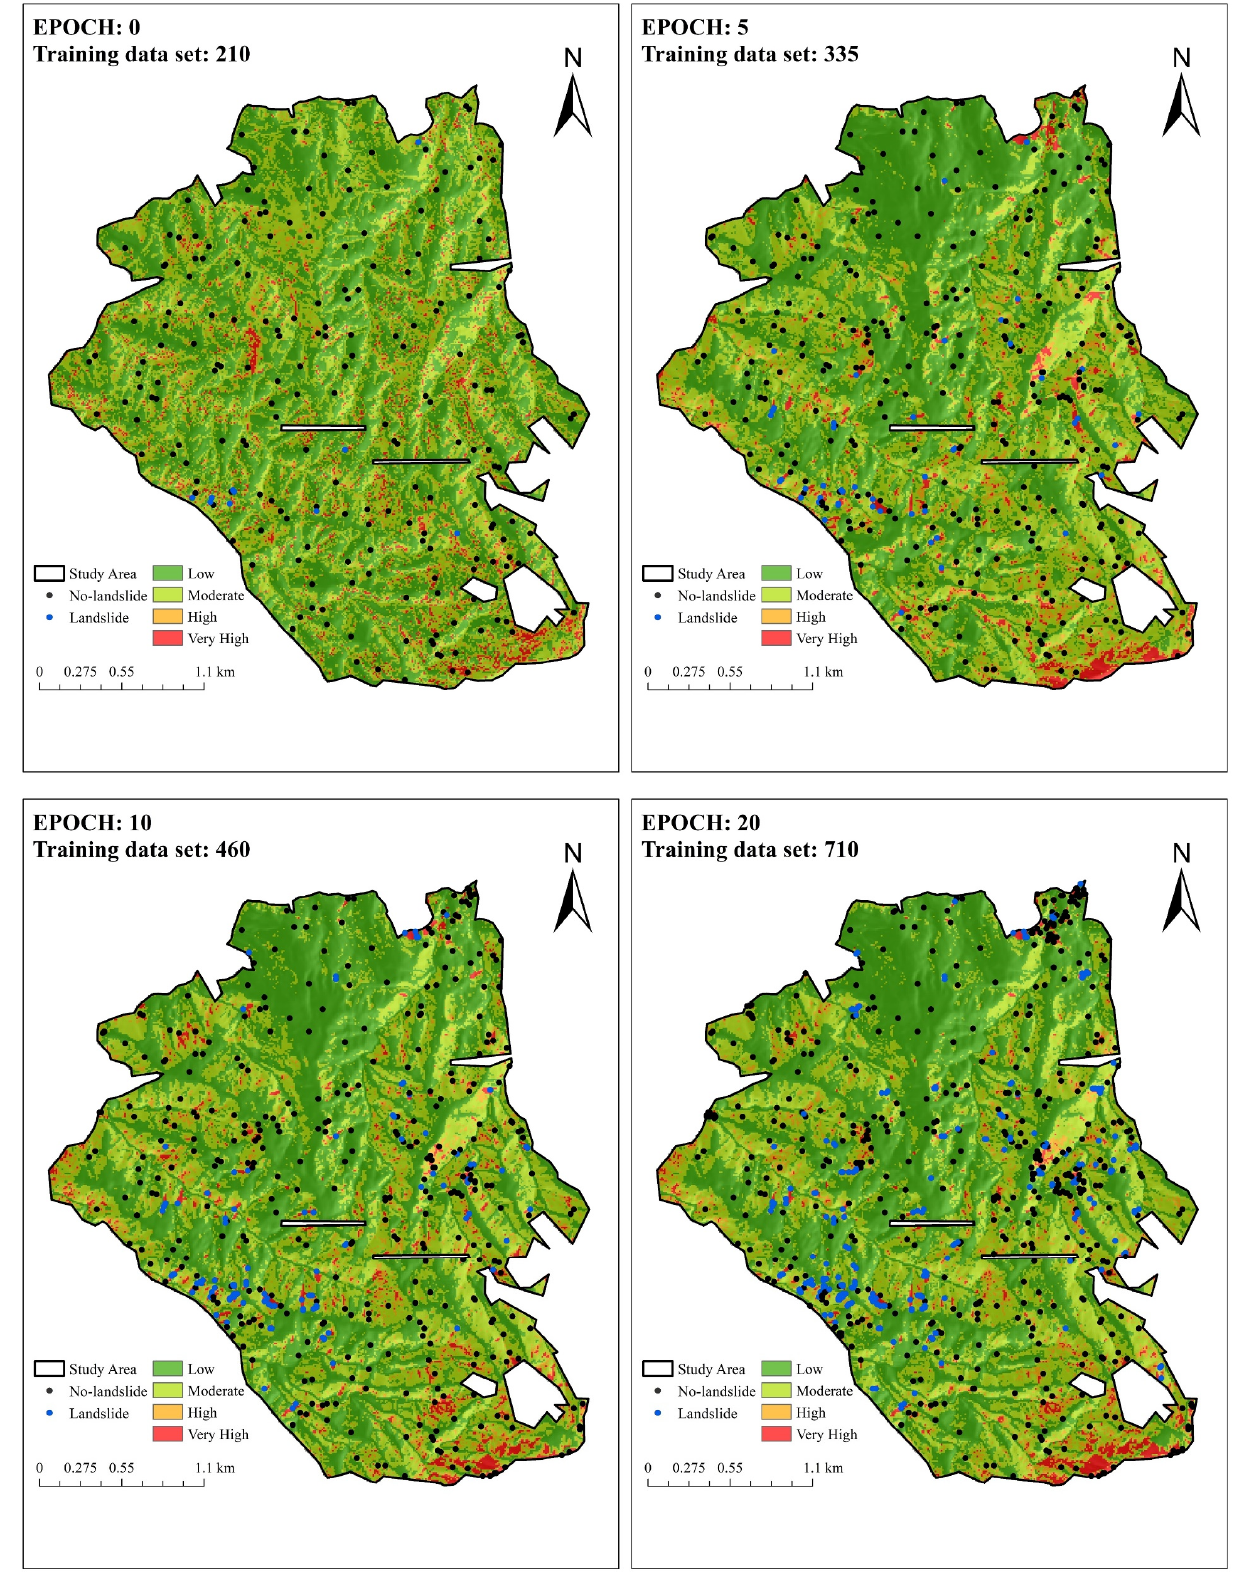
Figure 8. Landslide classification maps of SVM with margin sampling in epochs 0, 5, 10, and 20. Predicted probabilities are classified into four classes (very high, high, moderate, and low) using the top 4th, 10th, and 50th percentile as class boundaries.